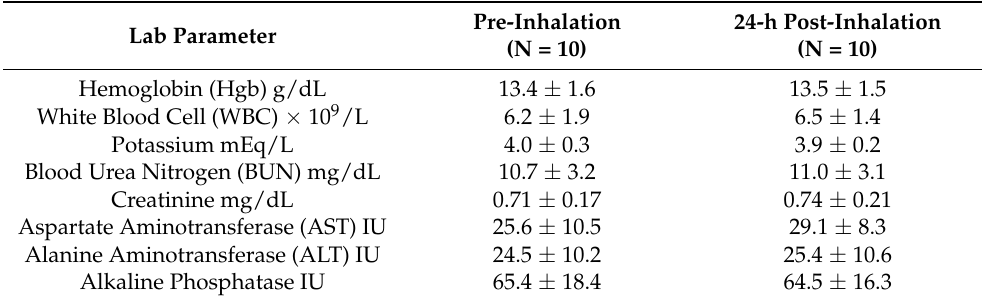
Table 4. Baseline and 24 h post-inhalation laboratory data with TAC-LAC dry powder for inhalation (3 mg TAC/dose).